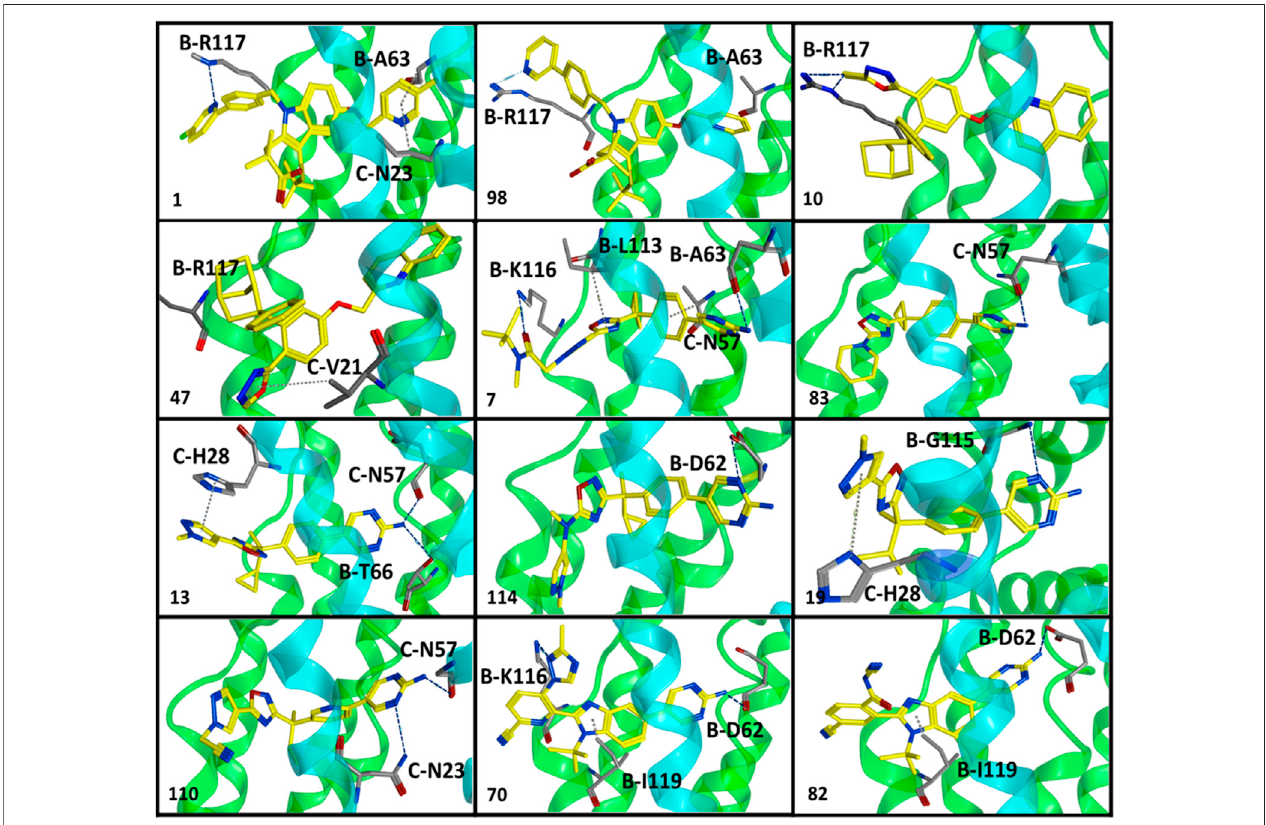
FIGURE 3 | Optimal binding poses of compounds displaying a distinct SAR pattern from all six classes of FLAP modulators. These poses were obtained from clusterswithmaximumdockedligands(commonscaffoldclustering)andwerefurtheremployedforGRID-independentmoleculardescriptor(GRIND)analysis.ChainBis shown in green while chain C is depicted in blue